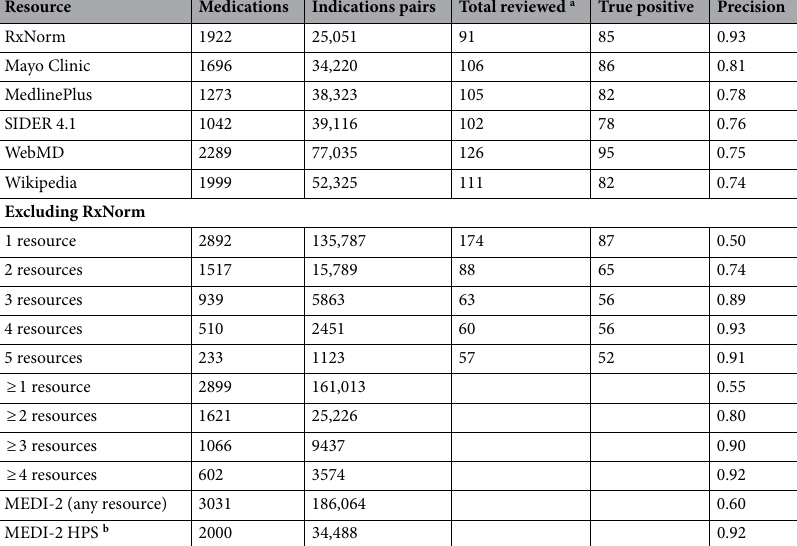
Table 2. Estimated precision of MEDI-2 for different resource combinations. a Indications that the reviewers deemed were too ambiguous were excluded from analysis (e.g., ICD10CM R69 = Illness, unspecified). b HPS: High precision subset = indications from RxNorm or ≥ 3